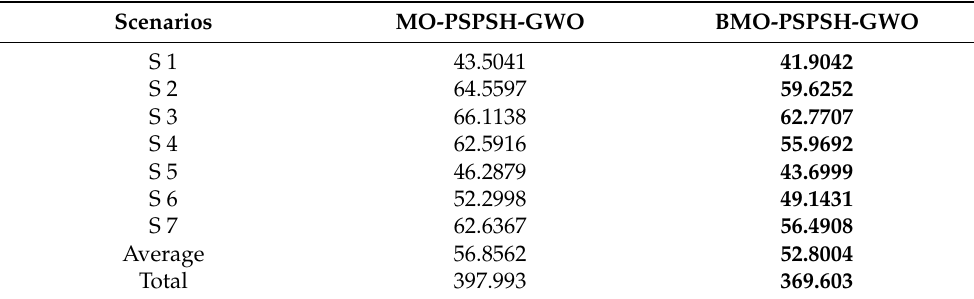
Table 6. Comparison between MO-PSPSH-GWO and BMO-PSPSH-GWO in terms of electricity bill (EB)